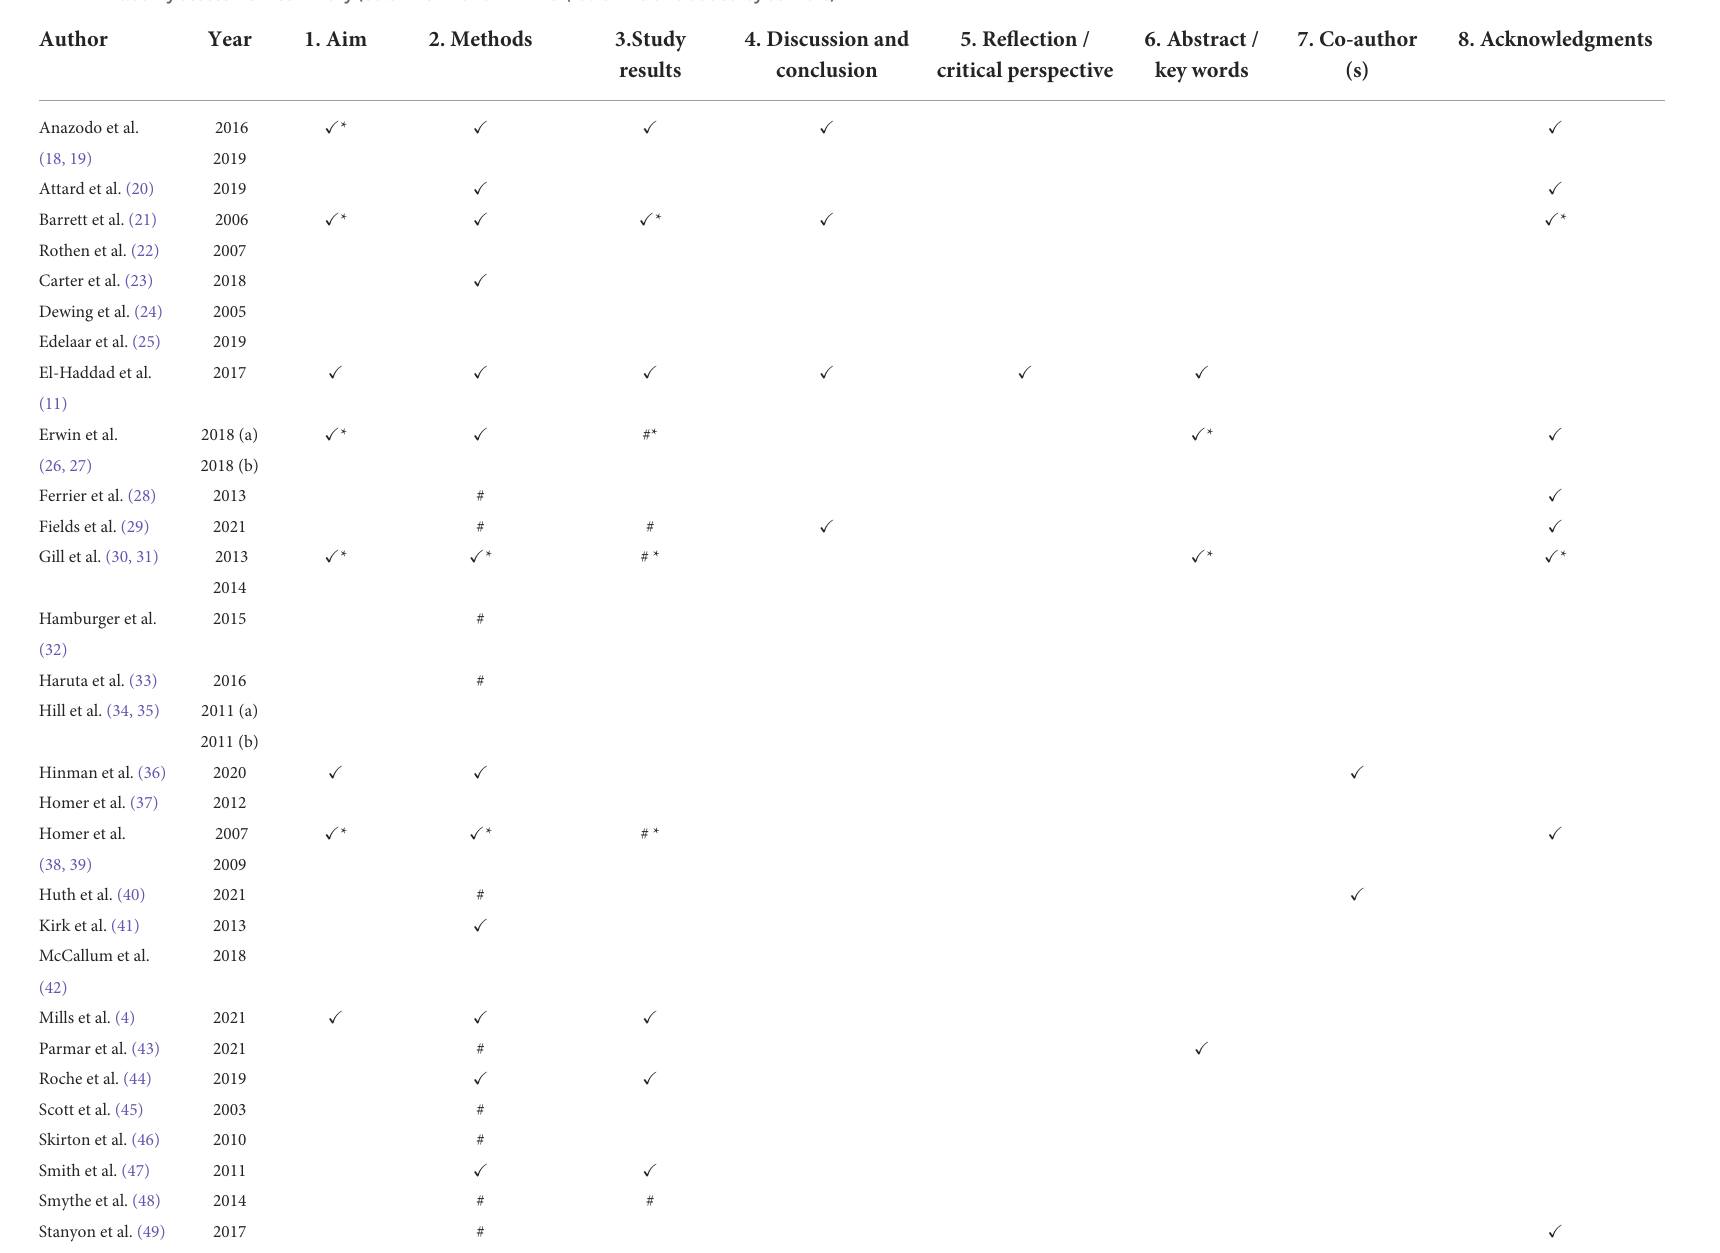
TABLE 1 Quality assessment summary (columns 1–5: GRIPP2-SF; columns 6–8 added by